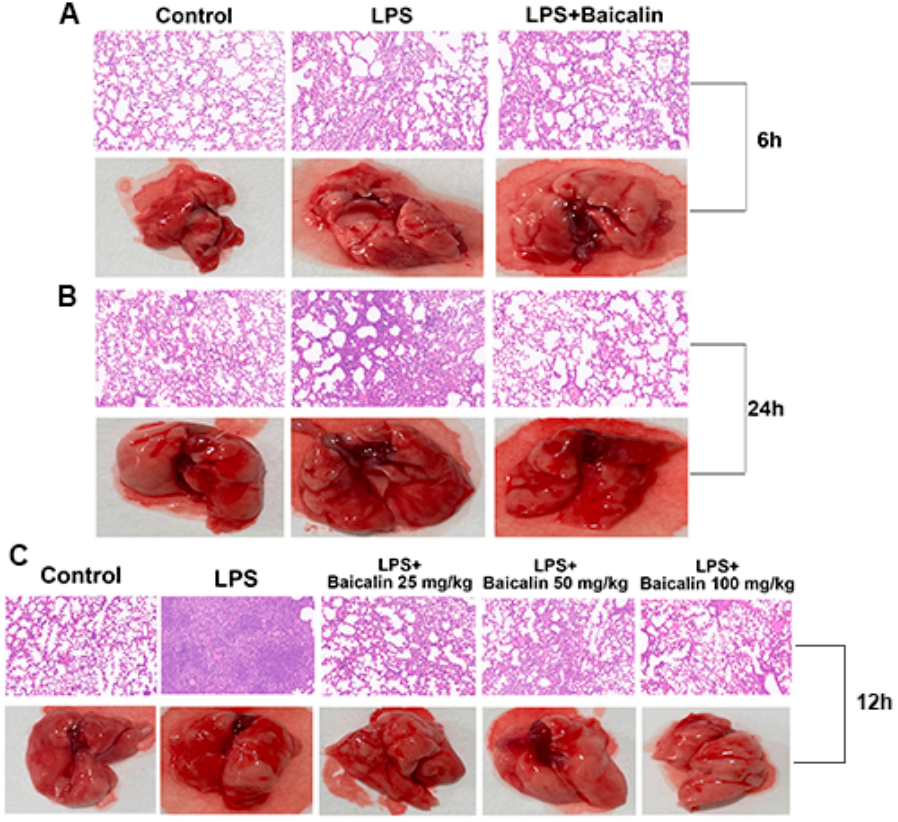
Figure 5. Effect of baicalin on lung tissue histopathological changes in LPS-induced ALI mice. LPS + baicalin group mice ( n = 6 per group) were given an intraperitoneal injection of baicalin (25, 50, and 100 mg/kg) 1 h prior to LPS administration. After 6 h, 12 h, and 24 h, lungs were harvested for measuring histopathological changes. To confirm pathological changes in lung tissues, hematoxylin– eosin (H&E) staining was performed: ( A ) Mice lung treated with LPS and baicalin for 6 h; ( B ) mice lung treated with LPS and baicalin for 24 h; ( C ) mice lung treated with LPS and baicalin for 12 h; the resolution was ×